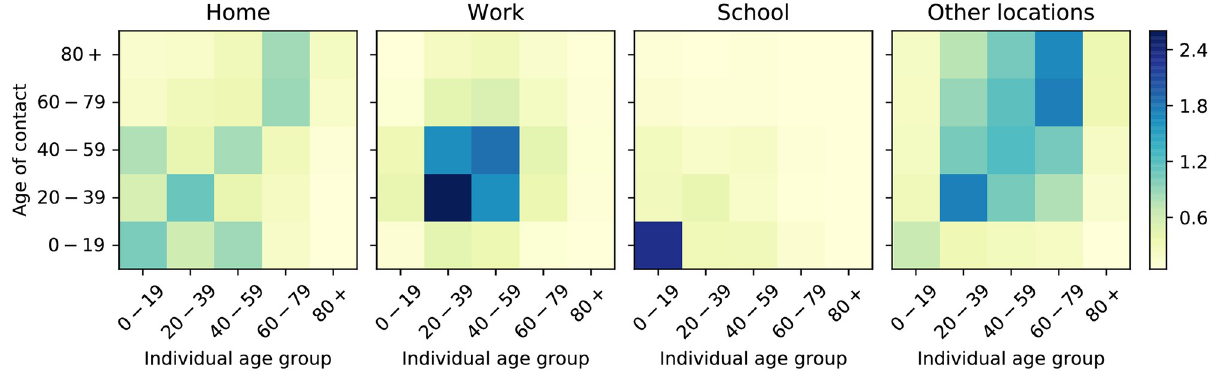
Fig 3. Contact matrices at different locations in the UK for the age groups used in the present study (0–19, 20–39, 40–59, 60–79, 80+); these are obtained by aggregating and combining the contact matrices for 5-year bands provided by [18] and [19].